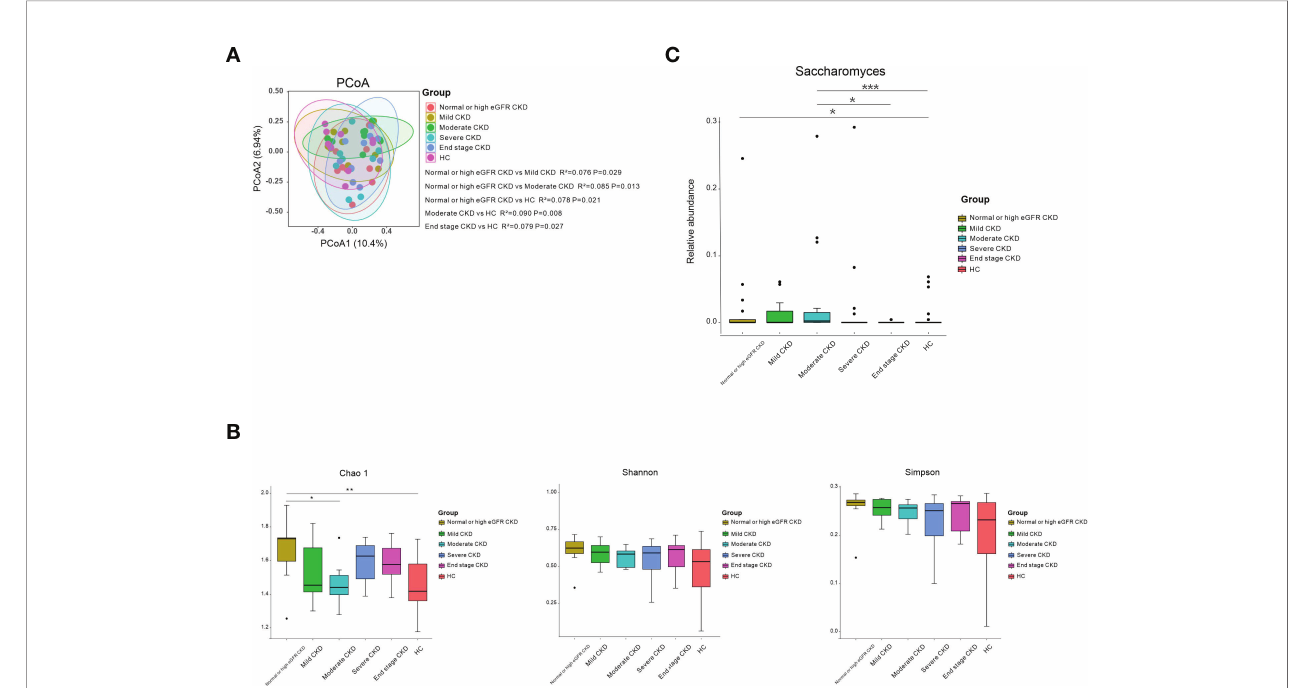
FIGURE 2 | Microbial community, diversity, composition, and Saccharomyces in the subgroups according to CKD stages and HC. (A) PCoA based on Bray – Curtis distances at the OTU level showed different microbial compositions between the subgroups of patients ’ renal function damage and HCs. Permutational multivariate analysis of variance (PERMANOVA) was performed for statistical comparisons of samples in the two cohorts. Patients with normal- or high-eGFR CKD/moderate CKD/end-stage CKD showed different microbial communities compared to HCs/mild CKD/moderate CKD ( P < 0.05). P -value was adjusted by the Benjamini and Hochberg FDR. (B) Bacterial richness and diversity measured by Chao1, Shannon, and Simpson were calculated at the microbial OTU level. Chao1 showed signi fi cantly higher in normal or high eGFR CKD in relation to HCs/moderate CKD (P < 0.05). Wilcoxon rank-sum test was performed and adjusted by the Benjamini and Hochberg FDR. * and ** indicate P < 0.05 and P < 0.01, respectively. (C) Comparison of the abundances of Saccharomyes in CKD patients from normal or high eGFR CKD to end-stage CKD and HC. *, **, and *** indicate P < 0.05, P < 0.01, and P < 0.001,